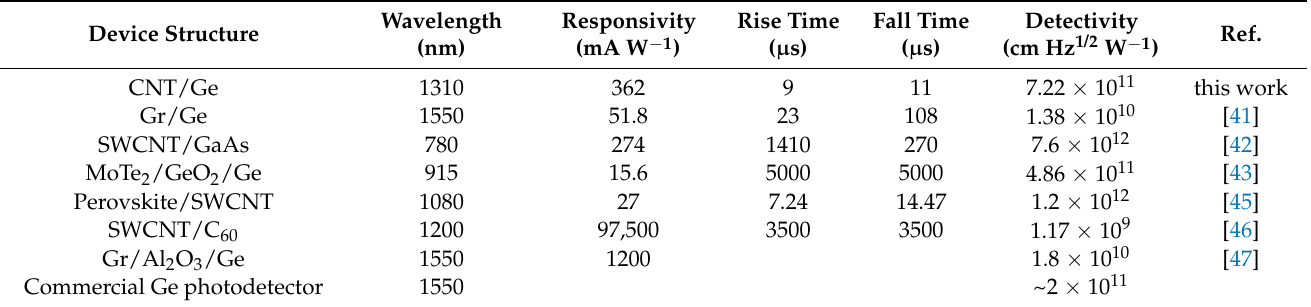
Figure 4. Performances of the ozone-treated SWCNT-Ge photodetector under the near-IR laser illumination. ( a ) Responsivity of SWCNT-Ge photodetector with different ozone treatment times, showing the maximum responsivity with 30 min treatment. The inset shows the I - V curves of the device with different ozone treatment times under laser illumination (1310 nm, 0.53 mW). ( b ) I - V curves of the ozone-treated SWCNT-Ge photodetector under different laser powers illumination; ( c ) A normalized cycle measurement at 1 kHz to estimate the response and recovery time. Table 1. Summary of the device performances of the CNT-Ge heterojunction photodetector and other similarly structured photodetectors.